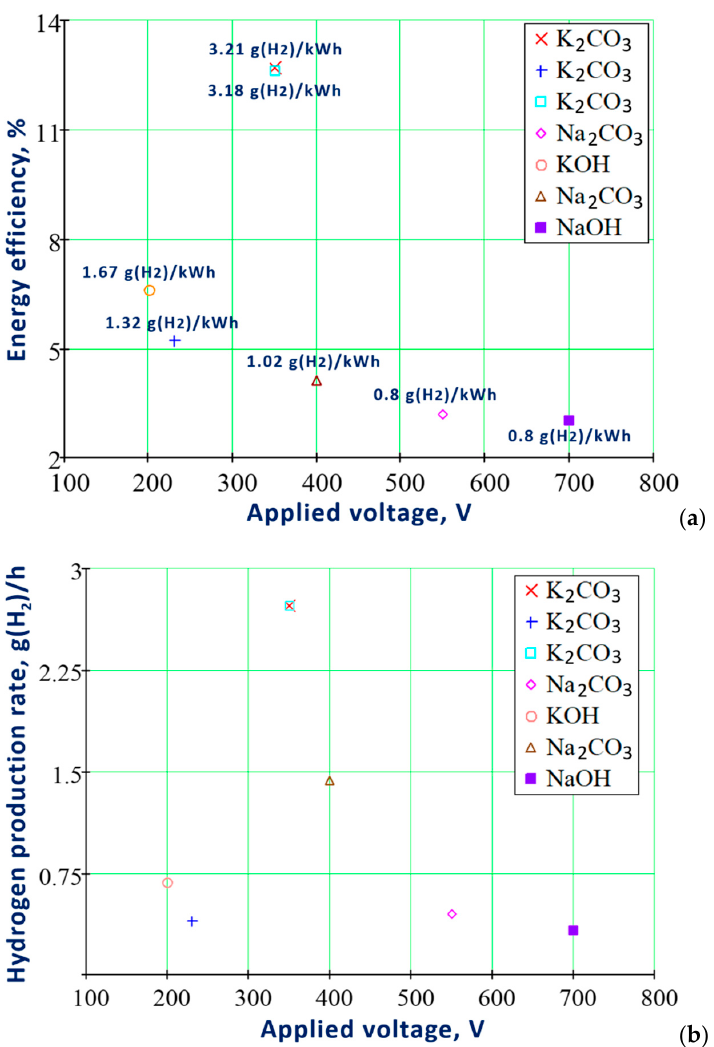
Figure 8. ( a ) Selective results regarding the energy efficiency (%) as a function of the applied voltage (V) in the cathodic regime of PDSE in the aqueous electrolytic solutions of potassium carbonate (K 2 CO 3 ), sodium carbonate (Na 2 CO 3 ), potassium hydroxide (KOH), and sodium hydroxide (NaOH) in various concentrations without organic additives (see details in Table 2). The numbers show the energy yields (g(H 2 )/kWh) of hydrogen production. ( b ) Selective results regarding the hydrogen production rate (g(H 2 )/h) as a function of the applied voltage (V) in the cathodic regime of PDSE in the aqueous electrolytic solutions of potassium carbonate (K 2 CO 3 ), sodium carbonate (Na 2 CO 3 ), potassium hydroxide (KOH), and sodium hydroxide (NaOH) in various concentrations without organic additives (see details in Table 2).